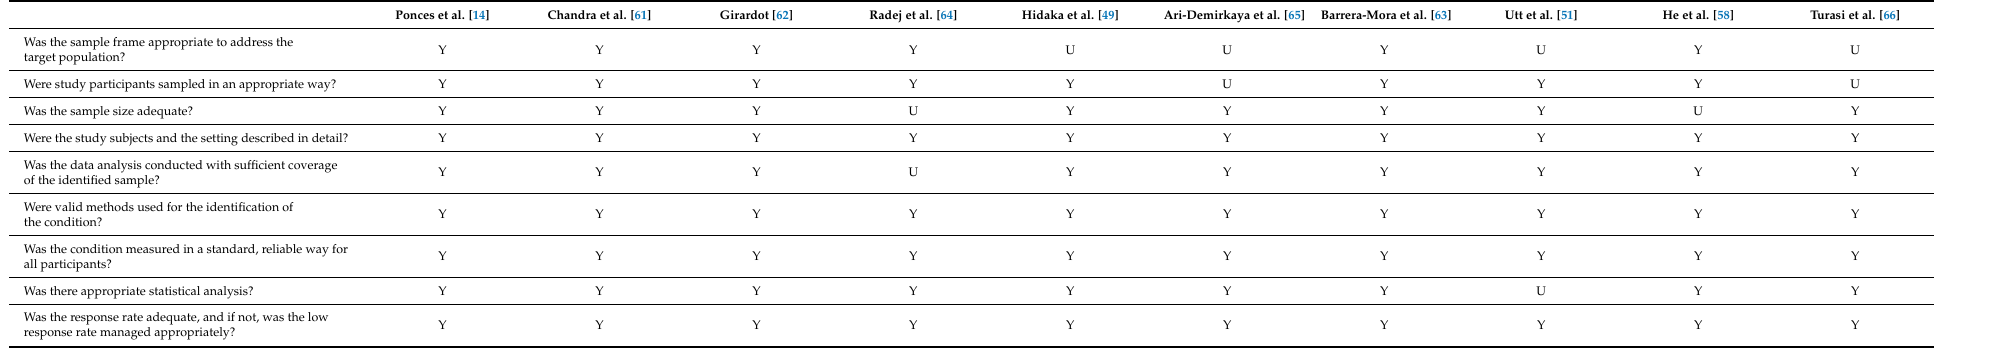
Table 2. JBL checklist for prevalence